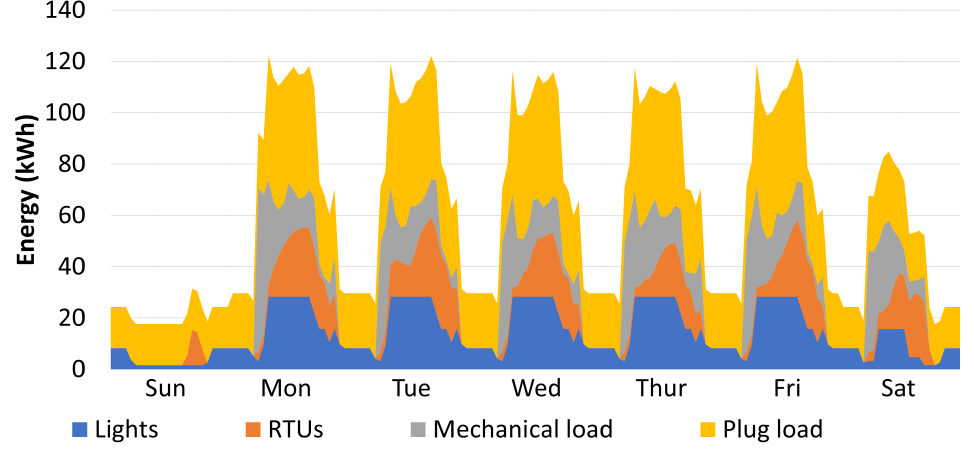
Figure 8. Hourly load profile of different building components for a week in